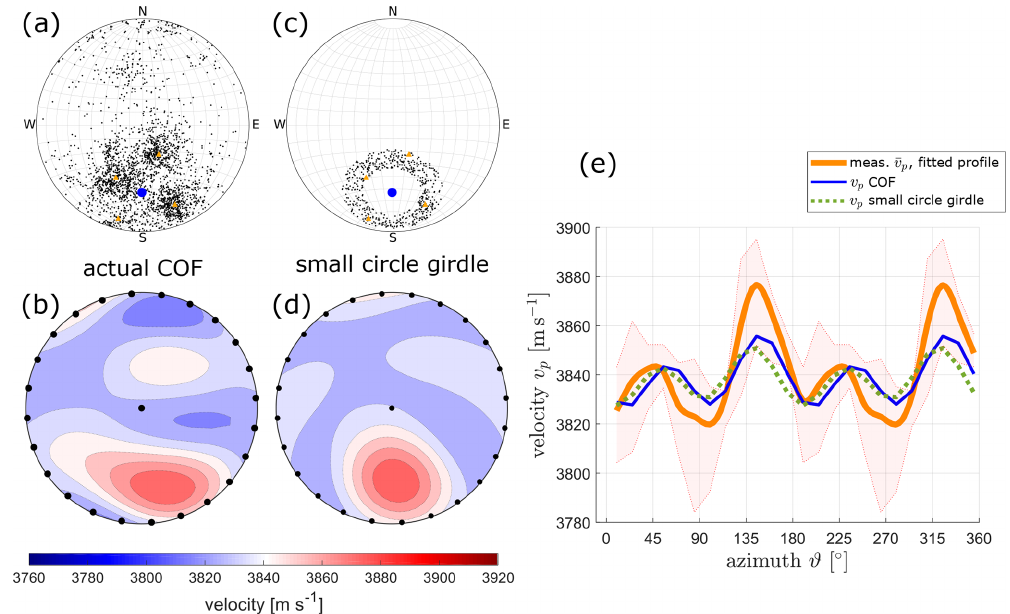
Figure 8. Comparison of different fabric types and their velocity profiles for different inclination angles: (a) lower hemisphere Schmidt plots for actual multi-maxima fabric for the sample from 22m and (b) the derived acoustic velocity pattern for (a) . (c) Lower hemisphere Schmidt plots for a modelled small circle girdle fabric and (d) the derived acoustic velocity pattern for (c) . The black dots in (b) and (d) symbolise the horizontal and vertical measurement positions. (e) The velocity profiles for horizontal measurements: orange line – actual measured profile, blue line – velocity profile of actual COF, and dashed green line – potential velocity profile for a small circle